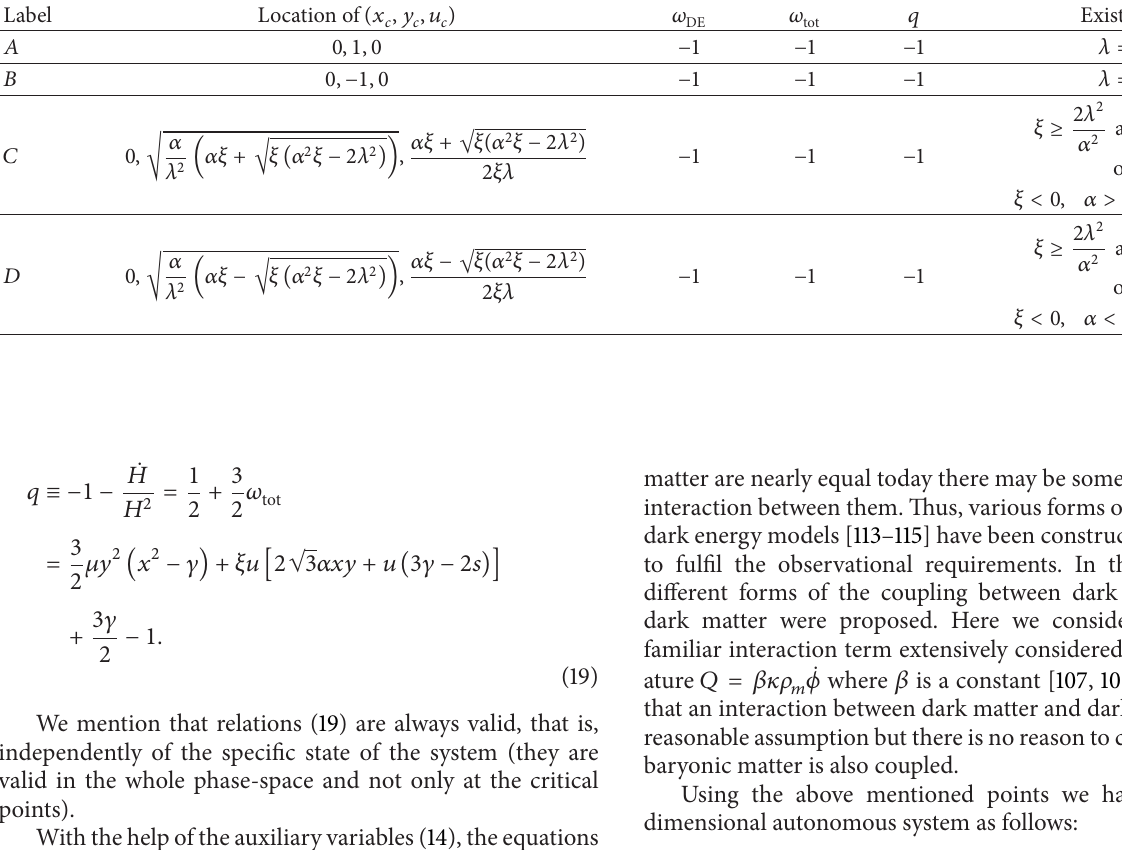
, and of the deceleration parameter 𝑞 . tot